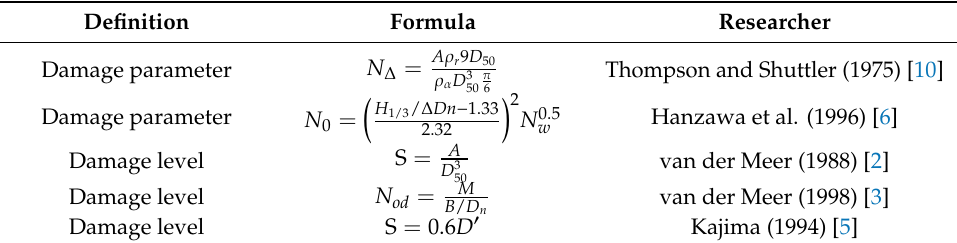
Table 1. Various definitions for the damage parameter (damage